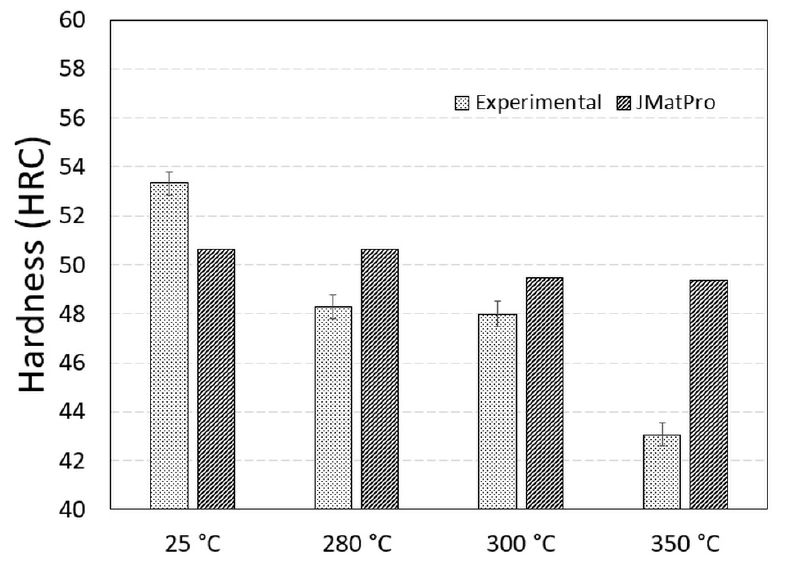
Figure 7. Average measured (experimental) and predicted (JMatPro) hardness (HRC) values accord- ing to heat treatment strategy from Figure 1.